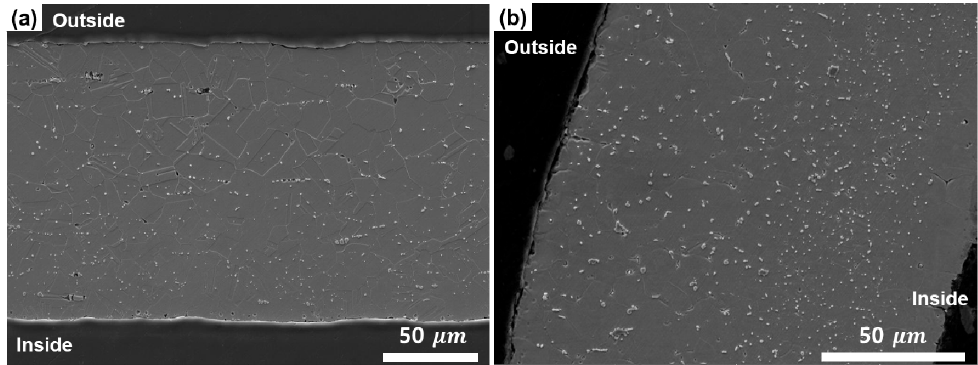
Figure 2. SEM images of an alloy 625 thin tube prior to the fatigue test: ( a ) longitudinal and ( b ) radial cross-sections.